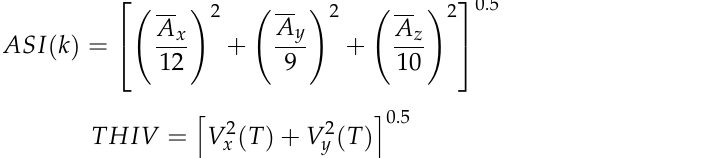
Figure 7. Vehicle coordinate system ( a ) and position of the acceleration transducers mounted at the center of gravity ( b ).